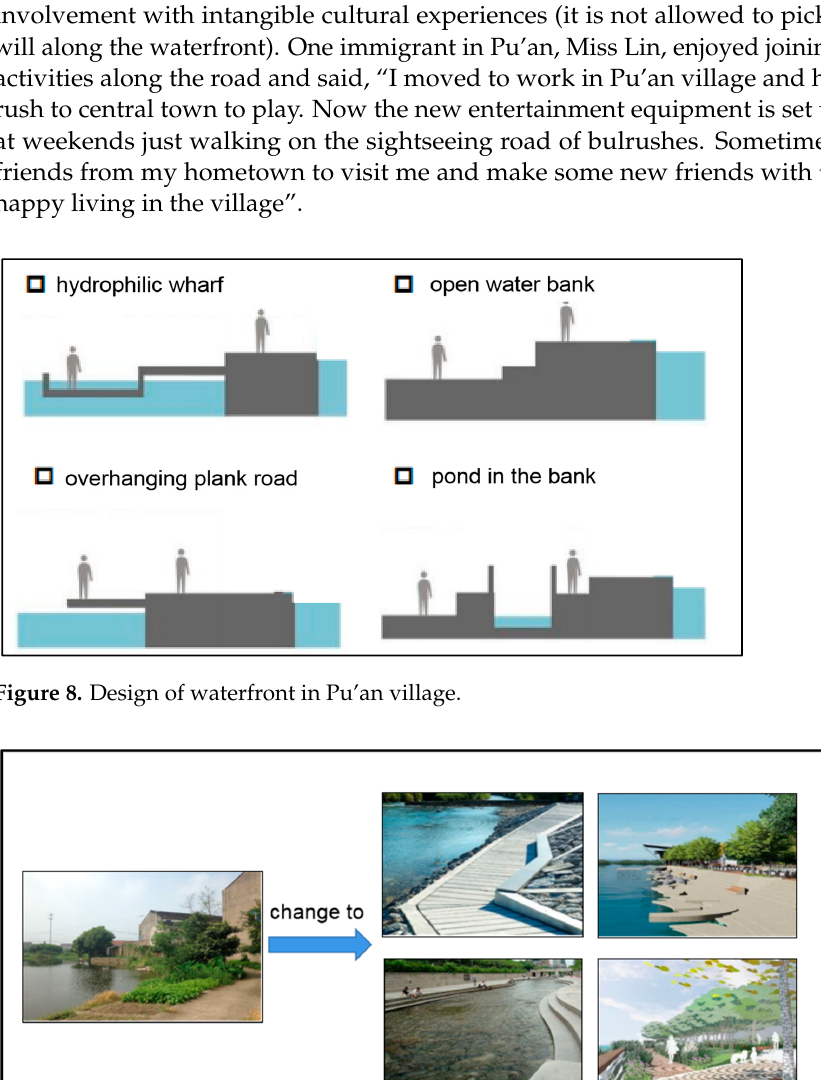
Figure 9. Example of design in terms of waterfront changes in Pu’an village.